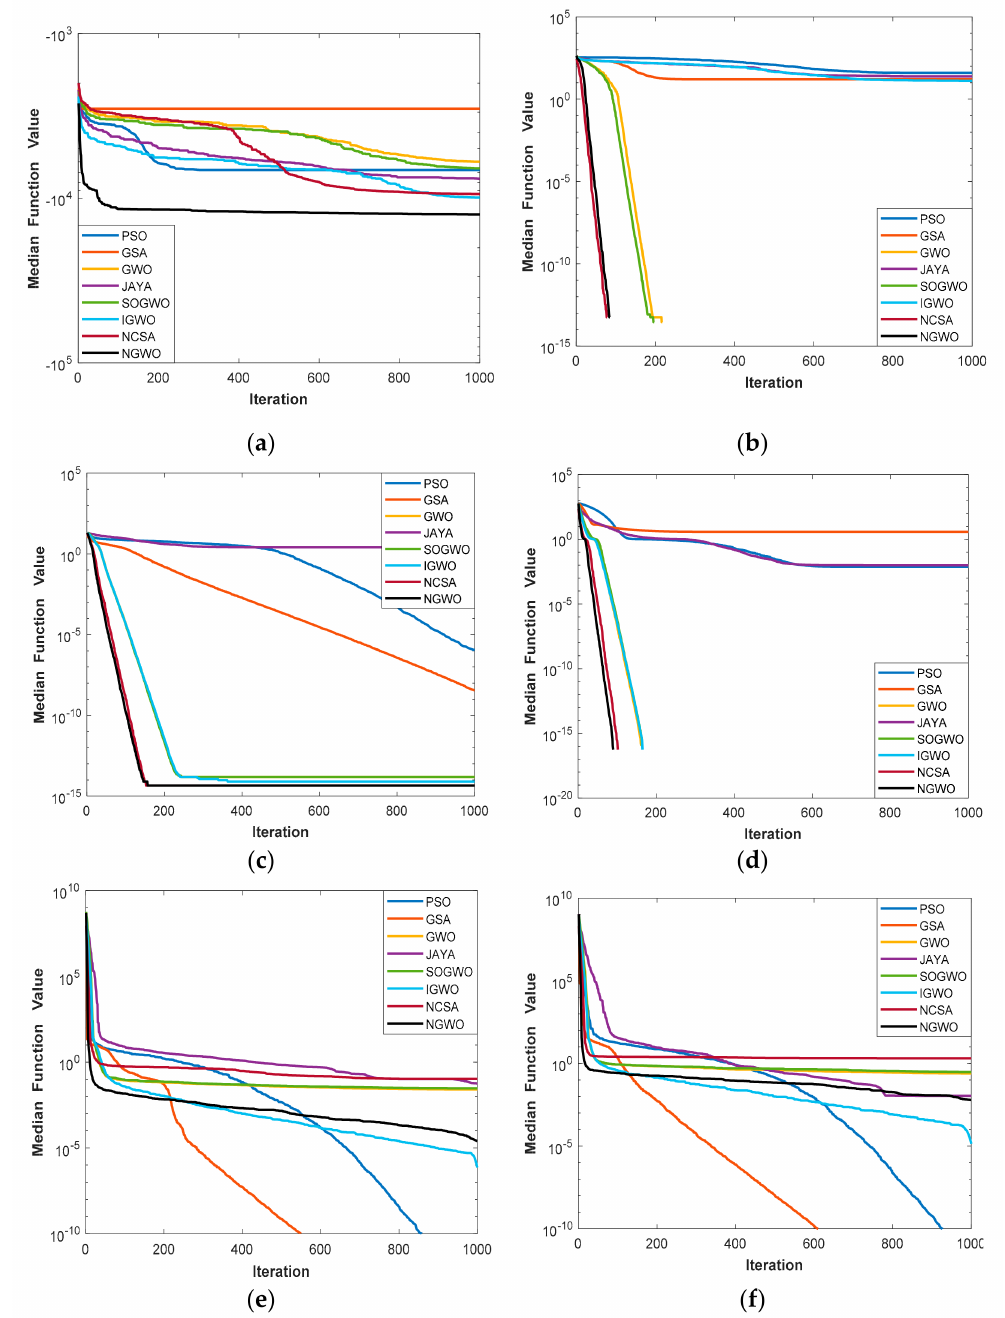
Figure 3. Convergence characteristics of the algorithms for multi-modal benchmark functions (F 8 -F 13 ). Here, ( a ) represents benchmark function F 8 , ( b ) represents benchmark function F 9 , ( c ) represents benchmark function F 10 , ( d ) represents benchmark function F 11 , ( e ) represents benchmark function F 12 , ( f ) represents benchmark function F 13